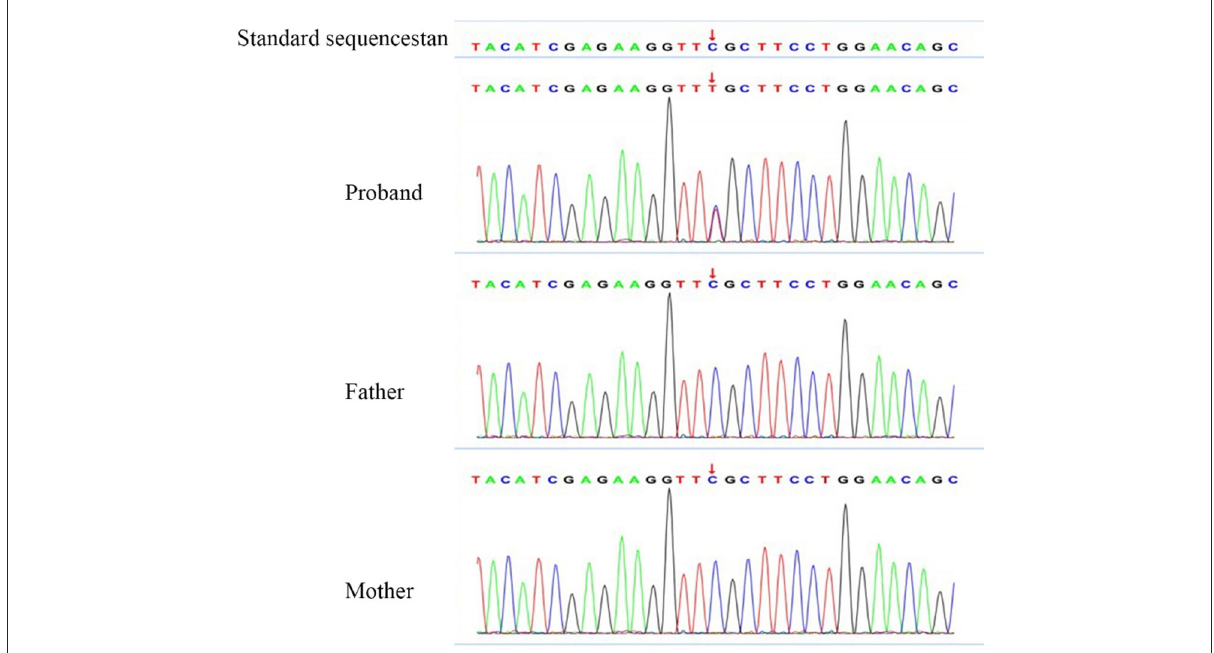
FIGURE3 Gene testing results. Location of the chromosome: Chr17:42992593. Gene mutation in c.262 (exon1) C > T was observed, due to the 88th amino acid change from arginine to cysteine. RS: 61622935. No variant was found in the parent.